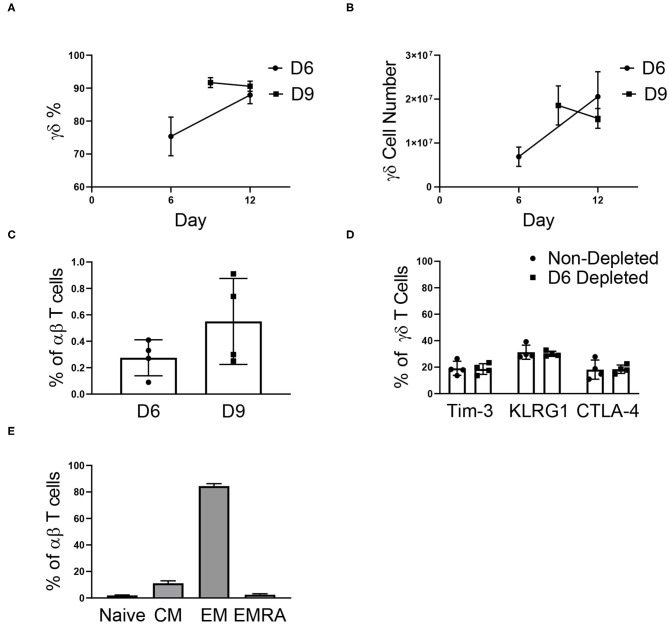
αβ depletions performed on day 6 (D6) and 9 (D9) of expansion (two independent experiments). (A) The percentage of γδ T cells post-depletion was lower when the depletion was performed on day 6 (n = 6) of expansion vs. day 9 (n = 6) of expansion, however by day 12 there was no difference in the percent of γδ T cells in culture. (B) The number of γδ T cells in culture post-depletion to the end of expansion followed the same trend as the percentage of γδ T cells in culture. (C) Following depletion, αβ T cells made up <1% of the culture. (D) Performing the αβ depletion did not induce senescence in the γδ T cells by the end of expansion, as compared to a non-depleted culture. (E) Flow cytometry was performed determine the proportion of naïve (CD27+CD45RA+), central memory (CD27+CD45RA–), effector memory (CD27–CD45RA–), and effector memory CD45RA+ (CD27–CD45RA+) αβ T cells in culture. Of the αβ T cells in culture on day 12, the majority of cells were of the EM phenotype.